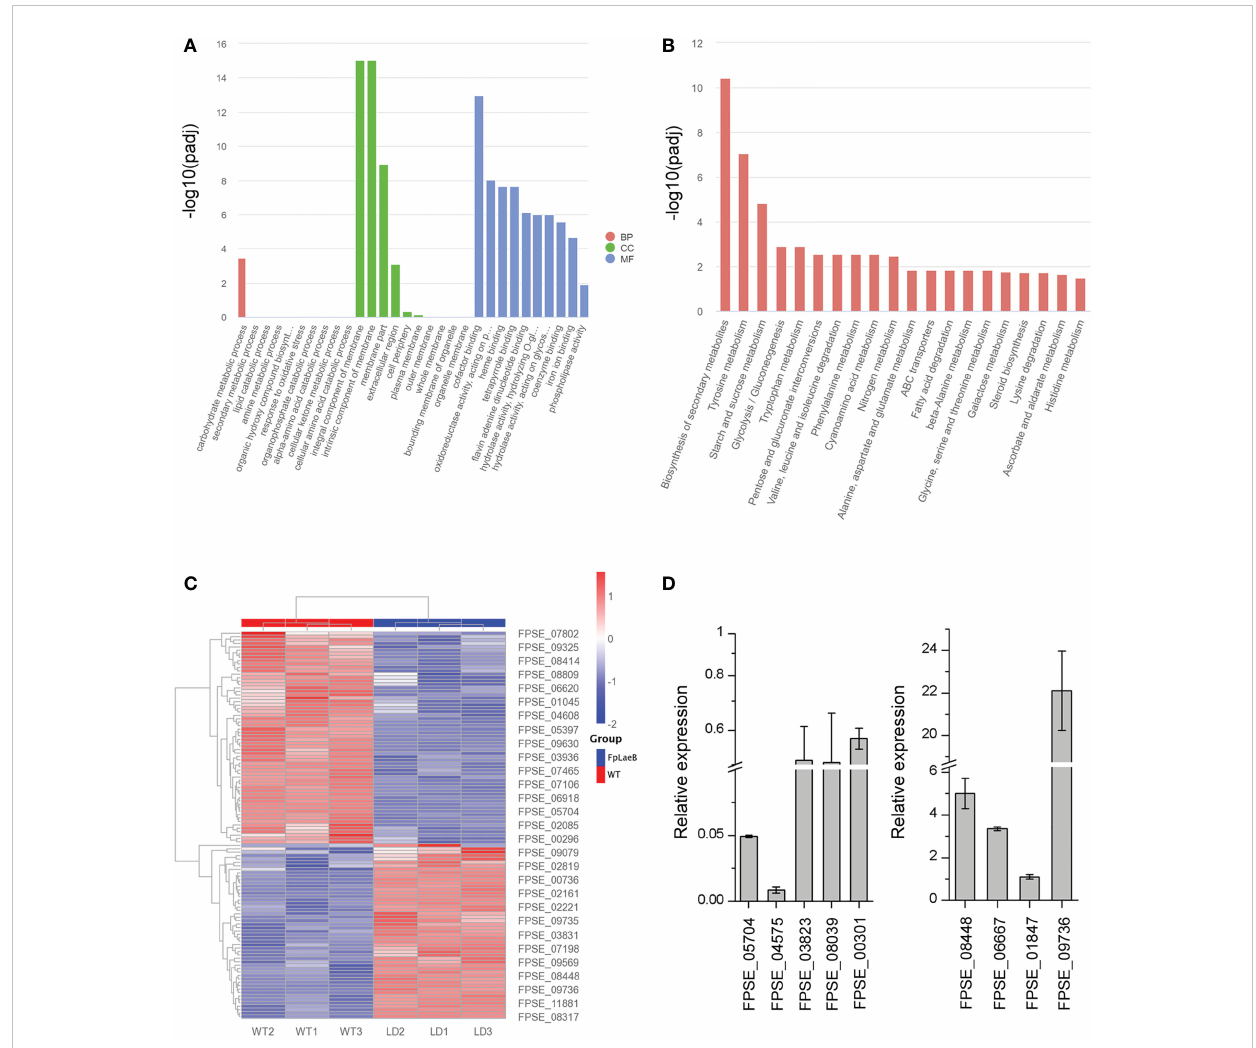
FIGURE 6 Transcriptome analysis of differentially expressed genes (DEGs) between the FpLaeB deletion mutant and wild type. (A) Bar plot of Gene ontology (GO) annotation of DEGs. The DEGs were categorised into three main categories: biological process (BP), cellular component (CC), and molecular function (MF). The DEGs were log2(FC) greater than 1.0 with a threshold at p and corrected p < 0.05. (B) Kyoto Encyclopedia of Genes and Genomes (KEGG) pathway enrichment analysis of DEGs. (C) Heatmap for differentially regulated genes encoding secondary metabolites (SMs). The different colour scale presents the counts of expression normalised by Z -score. (D) Real-time qPCR for nine DEGs encoding SM including fi ve upregulated genes and four downregulated genes between wild-type and FpLaeb mutants. Cycle threshold of FpActin gene was used to normalise the two samples. Expression levels of these genes in wild type were arbitrarily given a value of 1. Mean and standard deviation of data were calculated from three biological replicates. Statistical analysis was performed using Fisher ’ s LSD in